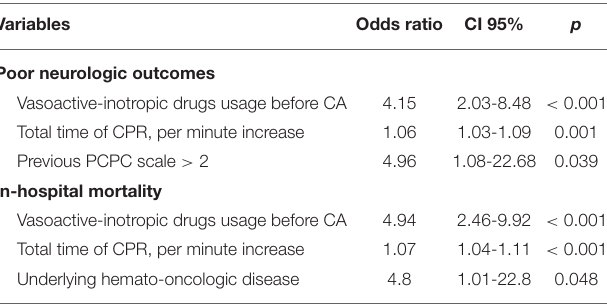
TABLE 2 | Multivariate logistic regression analysis for poor neurologic outcomes and in-hospital